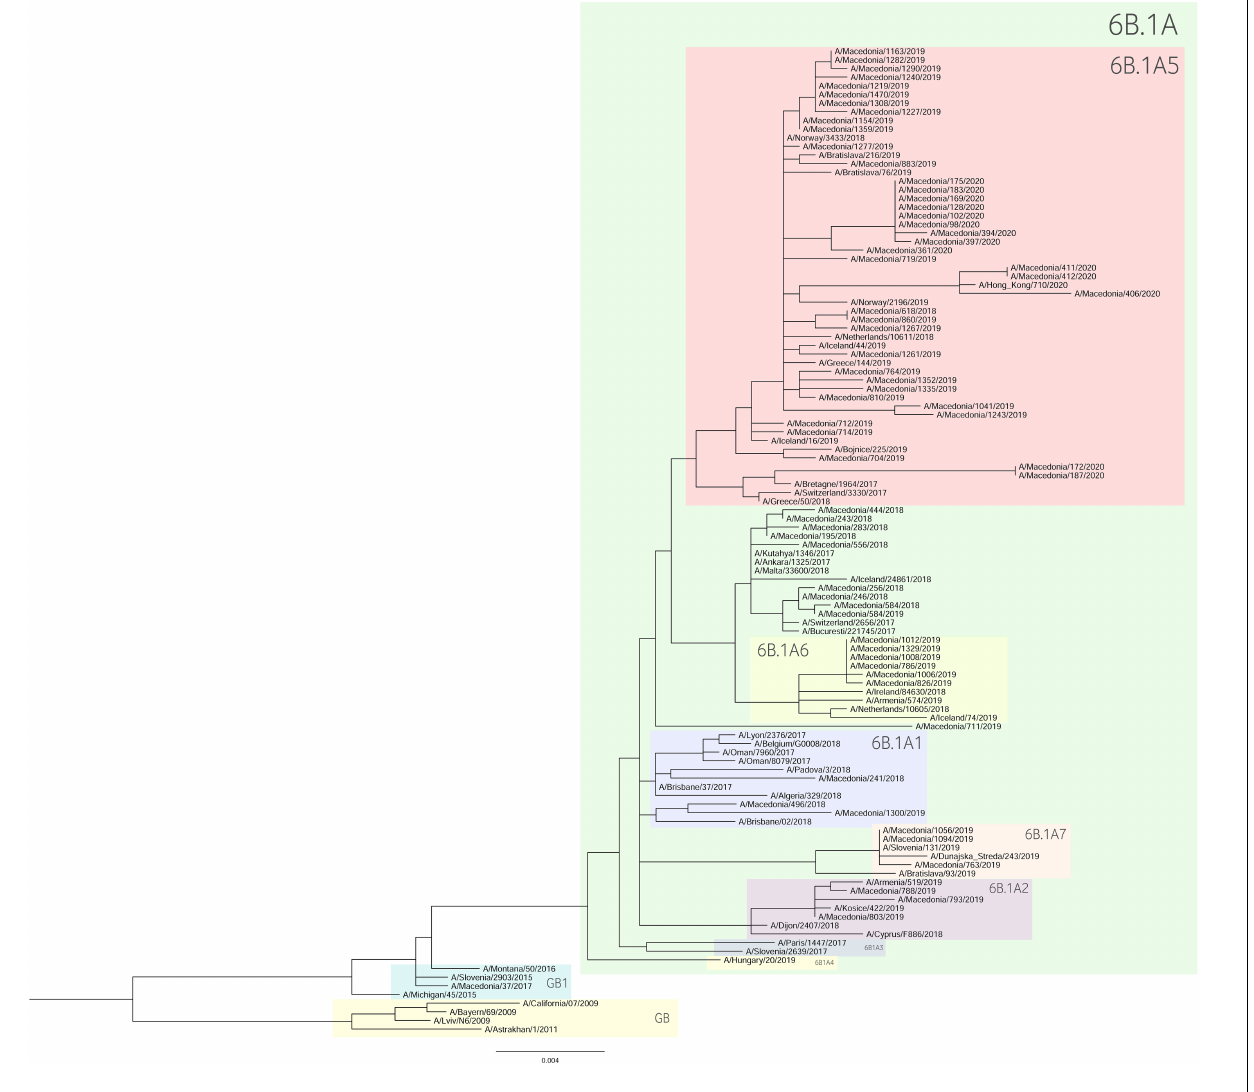
FIGURE 3 | A(H1N1)pdm09 HA phylogenetic